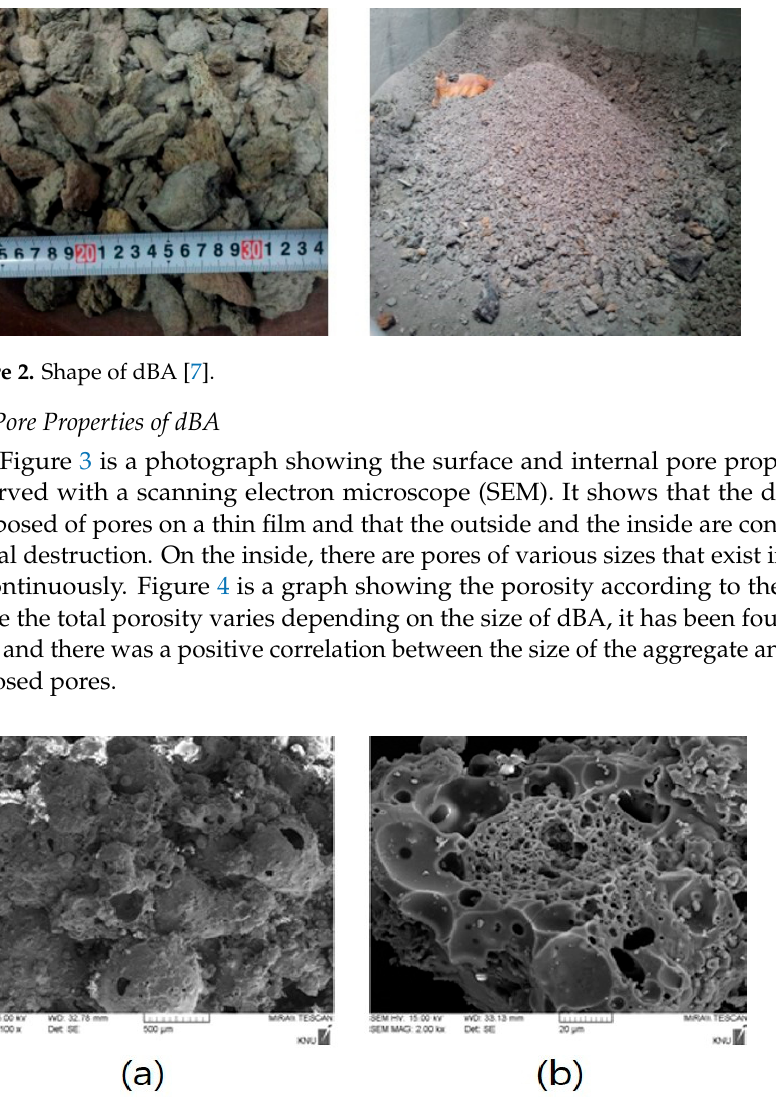
Figure 3. Pore properties of dBA; ( a ) Surface porosity of dBA; ( b ) Internal porosity of dBA.